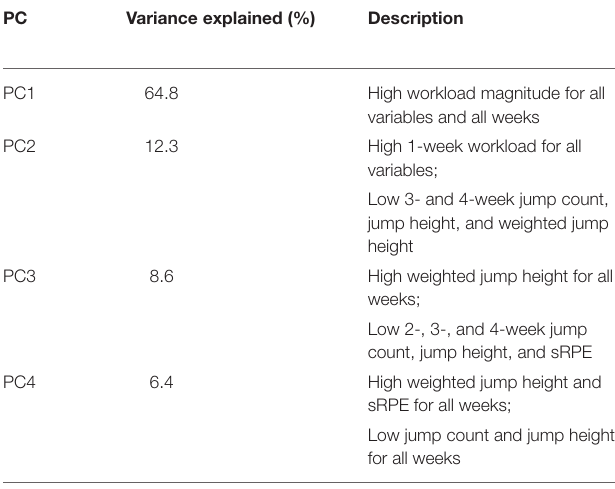
TABLE 2 | The retained PCs and their percent of total variance